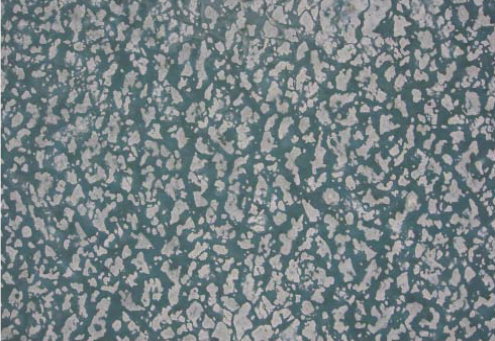
Figure 9. Example of aerial photo from MELTEX campaign in 2008, flight over landfast ice on 4 June 2008. The image width is approximately 400m. Only quality assessed images were taken (see text for